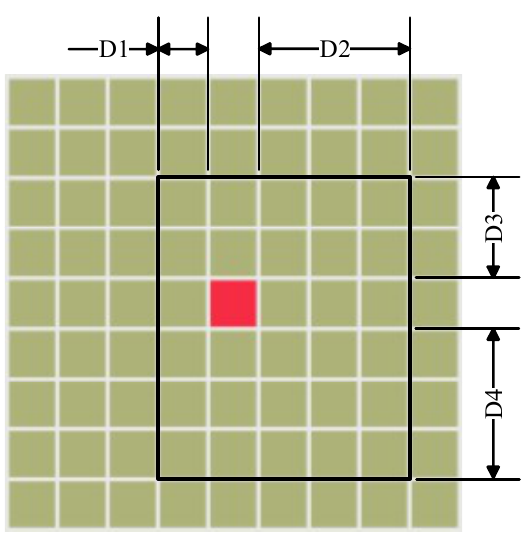
Figure 12. Schematic of the evaluation window.